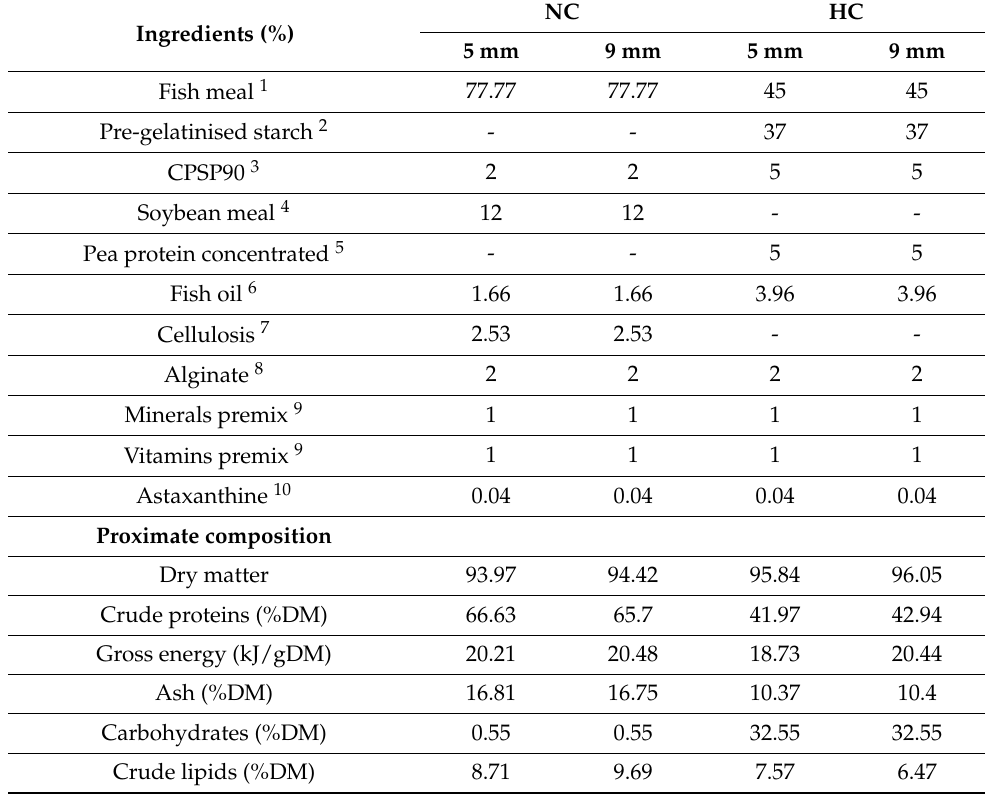
Table 4. Diet composition of the non-carbohydrate diet (NC) and the high-carbohydrate diet (HC).